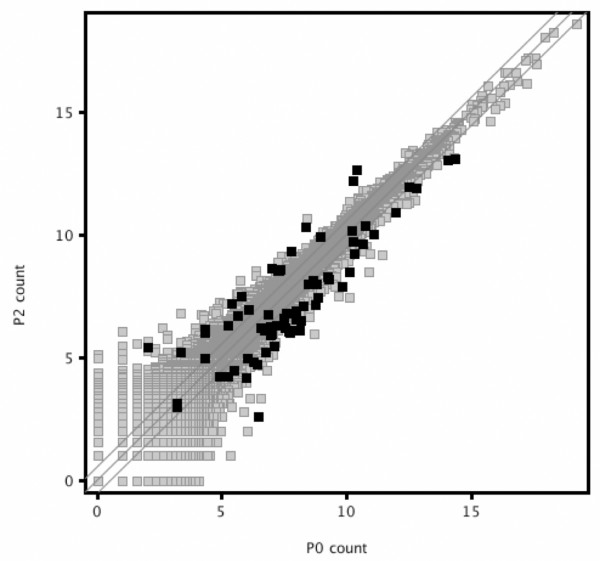
Scatter plot of the RNA-Seq expression data demonstrates that most of the microarray-defined genes with changing levels of expression (bold) have a concordant change by RNA-Seq. The plot is on a log2 transformed scale.